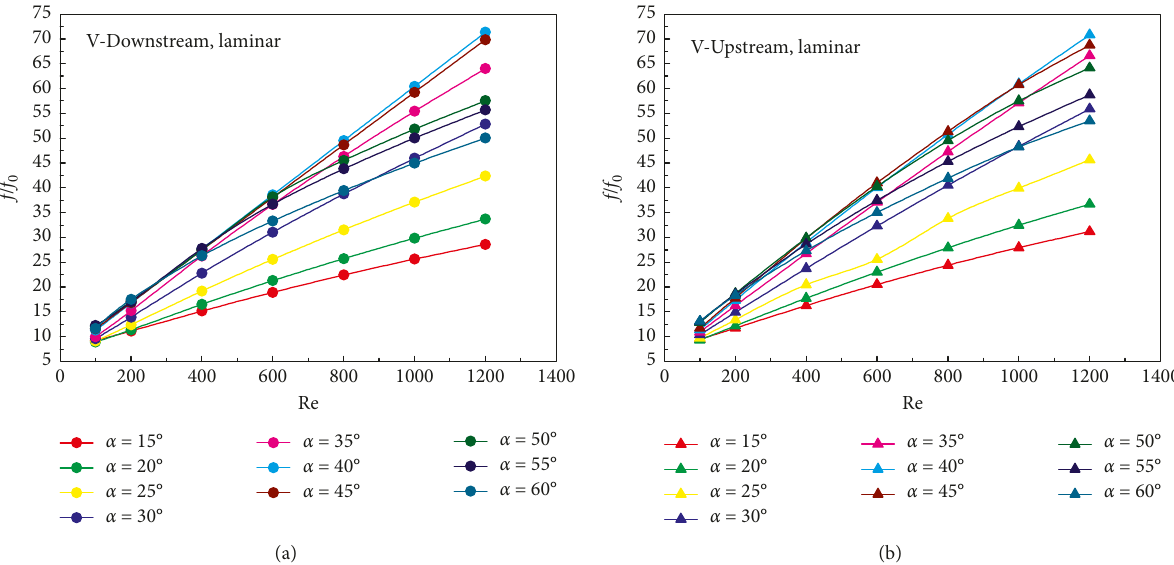
Figure 10: Relations of f / f 0 with Re for the heat exchanger tube inserted with the V-wavy surface for (a) V-Downstream and (b) V-Upstream at the laminar